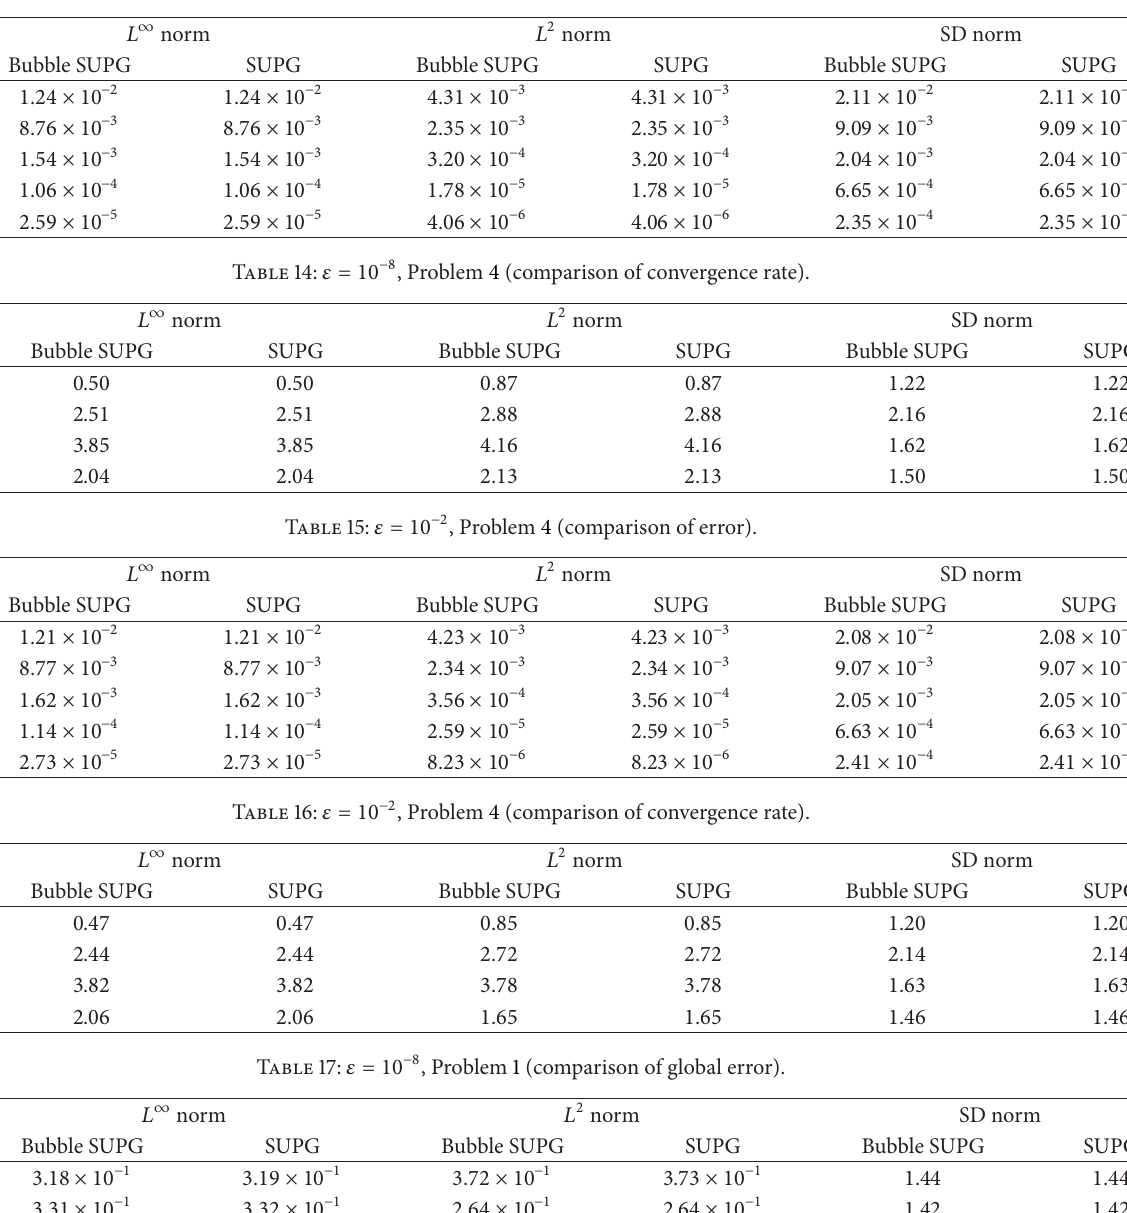
Table 13: 𝜀 = 10 −8 , Problem 4 (comparison of error).